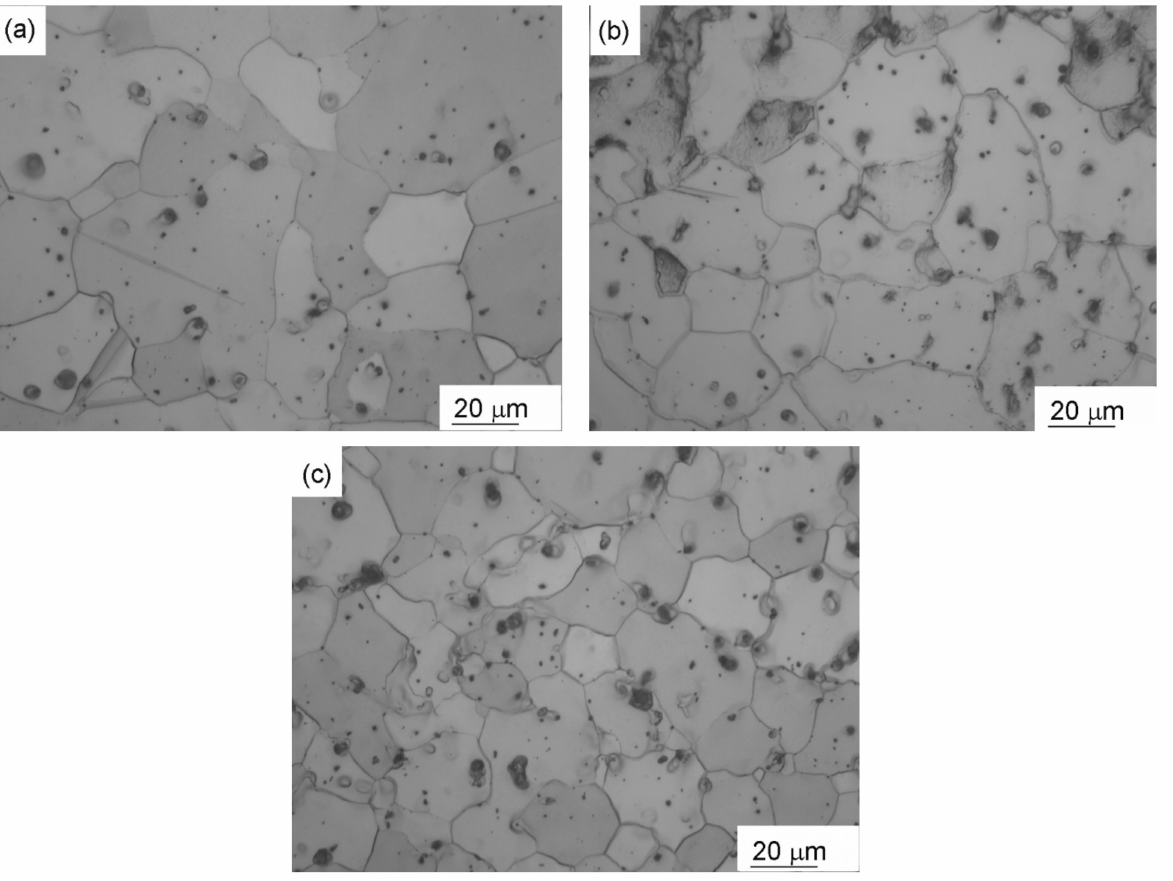
Figure 7. HAZ optical microstructure of AZ31 welded joint prepared with different welding